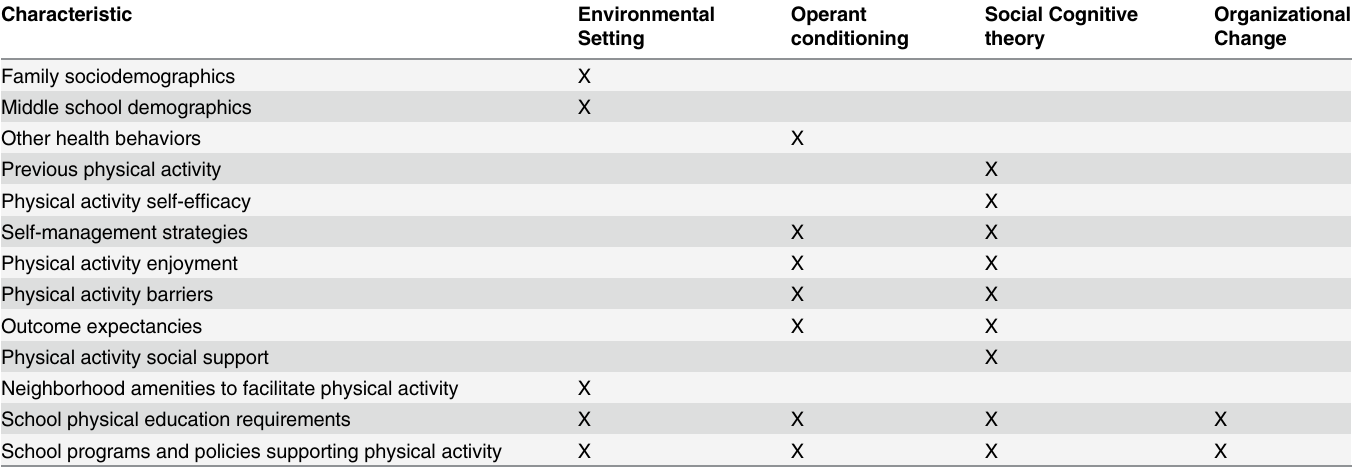
Table 1. Description of how key constructs apply to the settings and theories included in the Trial of Activity for Adolescent Girls Social Ecological Framework. Characteristic Environmental